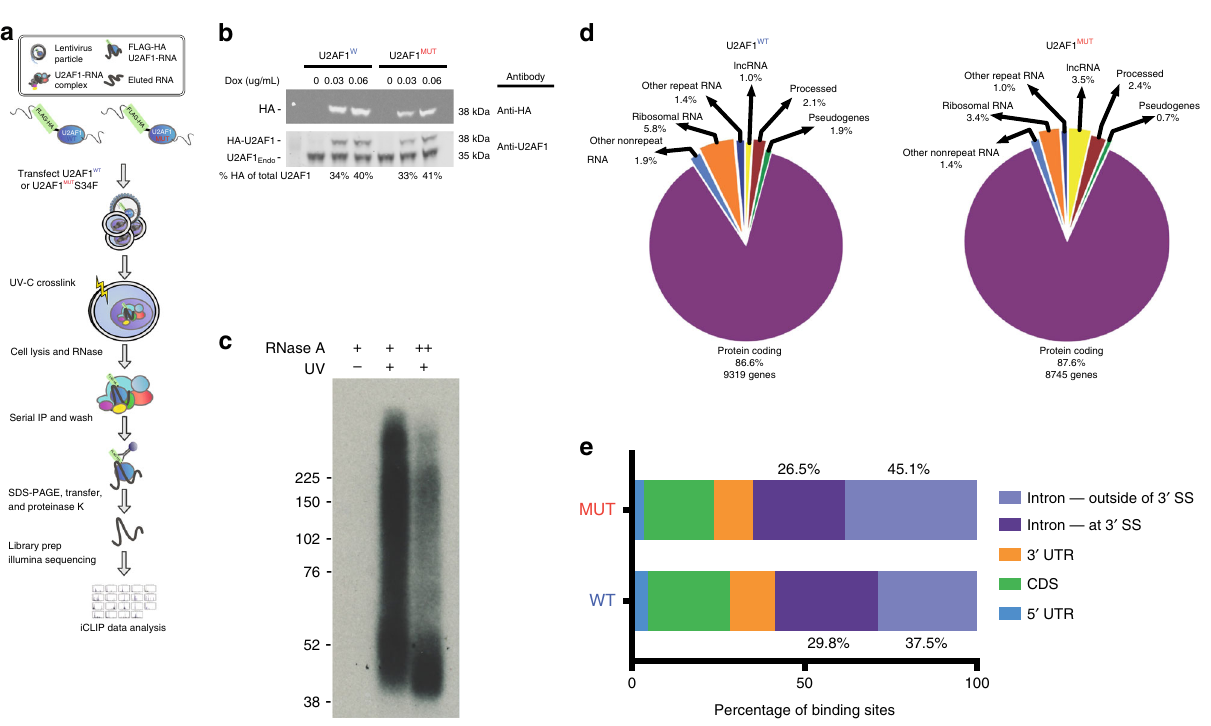
Fig. 2 Genome-wide mapping of RNA interactions for wild-type and S34F mutant U2AF1. a Schematic illustration of U2AF1 iCLIP. IP, immunoprecipitation; RNase, ribonuclease. Doxycycline-inducible FLAG-HA-tagged wild-type and S34F-mutant U2AF1 plasmids were transfected into HCC78 cells. Induced lysates were puri fi ed on anti-Flag-M2 agarose beads followed by a series of wash steps to speci fi cally elute FLAG peptide-containing complexes and recaptured with anti-HA agarose. Standard iCLIP steps were subsequently performed to generate deep sequencing libraries. b Western blots were performed to con fi rm doxycycline induction of FLAG-HA-U2AF1 wild-type and S34F mutant constructs utilizing anti-HA and anti-U2AF1 monoclonal antibodies. Percent of HA-tagged U2AF1 of total U2AF1 is shown. c Autoradiogram of 32 P-labeled RNA crosslinked to Flag-HA-U2AF1 trimmed with two different concentrations of RNase A. RNA-protein complexes are seen in the puri fi cations from Flag-HA-U2AF1 cells but not from the parental control cell line, HCC78. d Genomic distribution of U2AF1 iCLIP reads. lncRNA, long noncoding RNA. Wild-type and mutant U2AF1 iCLIP reads were annotated to known repetitive and non-repetitive regions of the human genome with percentage of total iCLIP reads shown. e Binding distribution of wild- type and S34F mutant U2AF1 iCLIP reads. UTR untranslated region, CDS coding sequence; 3 ′